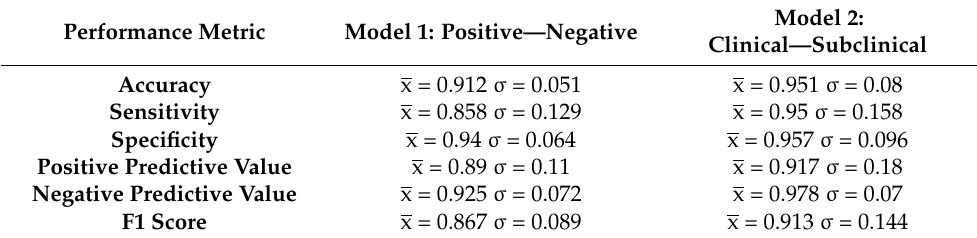
Table 2. Performance metrics of models on the test set, 10-fold nested cross-validation. Performance